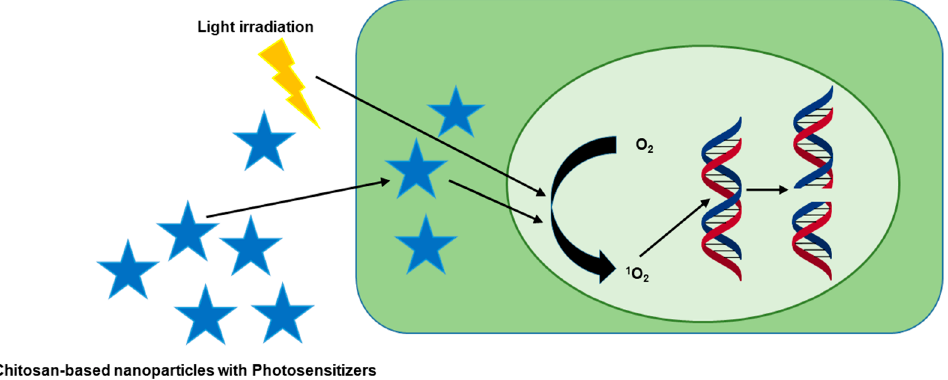
Figure 3. Photodynamic therapy mediated by chitosan-based complexes. Some chitosan-based complexes contain photosensitizers that localize into tumor cells. Upon irradiation at a specific wave- length, the photosensitizers convert O 2 to 1 O 2 which destroys cancer cells via photodynamic therapy.